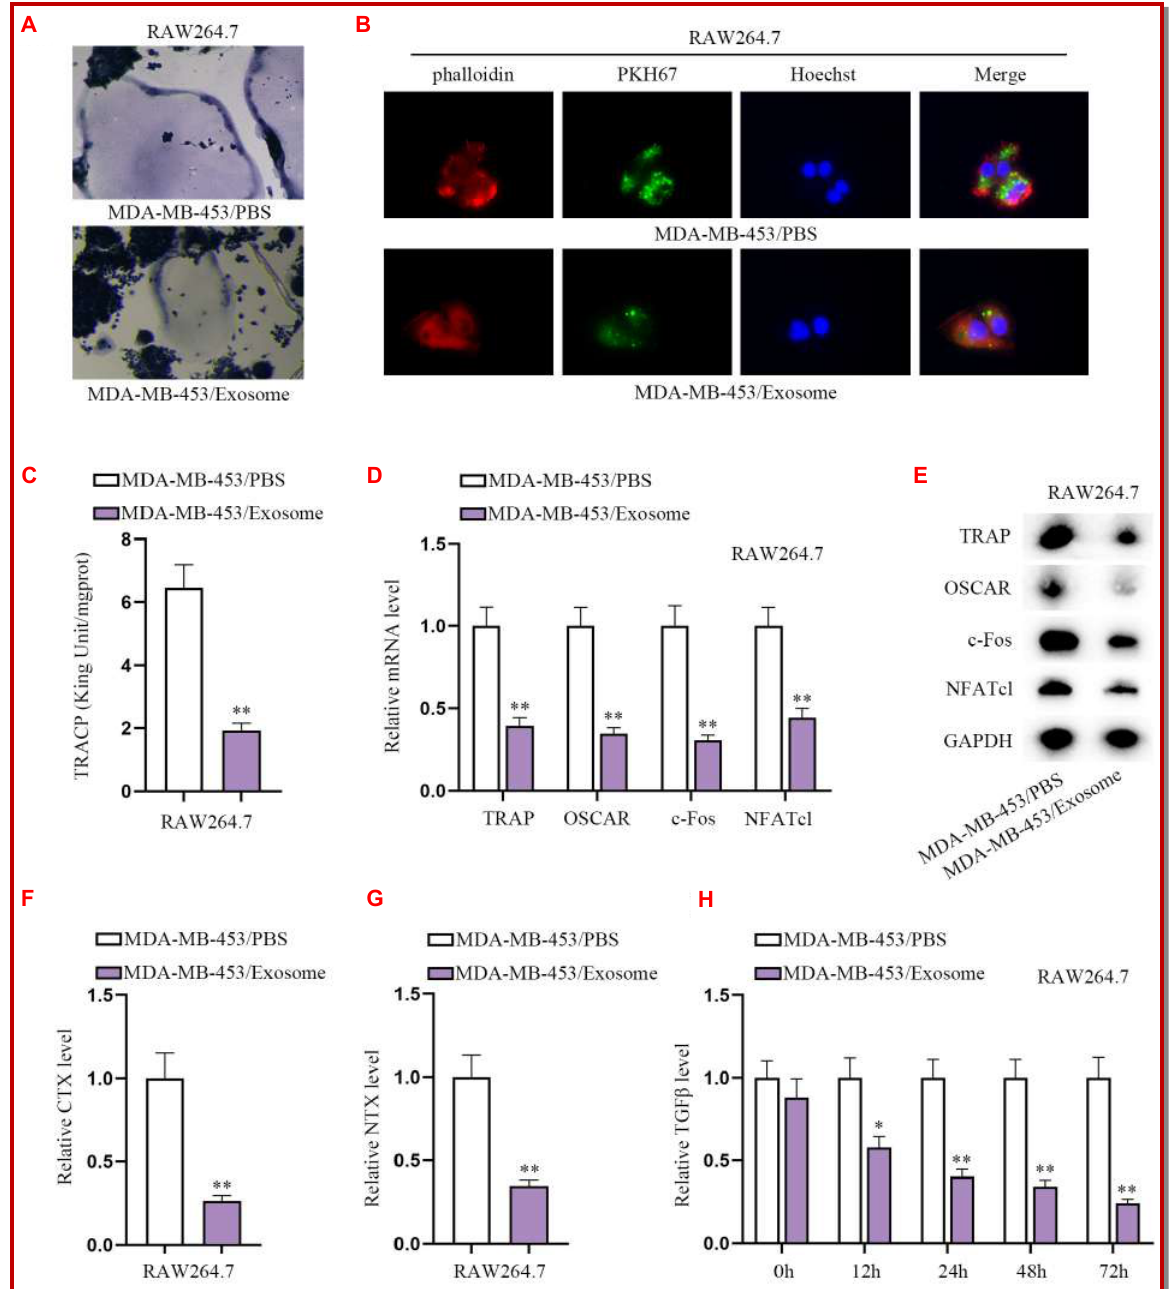
Figure 3: Exosomes derived from zoledronic acid-treated MDA-MB-453 cells inhibited the differentiation and maturity of osteo- clasts. The differentiation of osteoclasts was evaluated by TRAP staining assay (A). The identification of osteoclasts tracing the location of exosomes in RAW 264.7 cells were determined by immunostaining assay on phalloidine and PKH67, respectively (B). The quantification of TRAP staining assay was recorded (C). The gene expression level of TRAP, OSCAR, c-Fos, and NFATcl was determined by RT-PCR (D). The protein expression level of TRAP, OSCAR, c-Fos, and NFATcl was determined by Western blot- ting (E). The concentration of CTX was measured by the ELISA assay (F). The concentration of NTX was measured by the ELISA assay (G). The concentration of TGF- β was measured by the ELISA assay (H) (p<0.05,